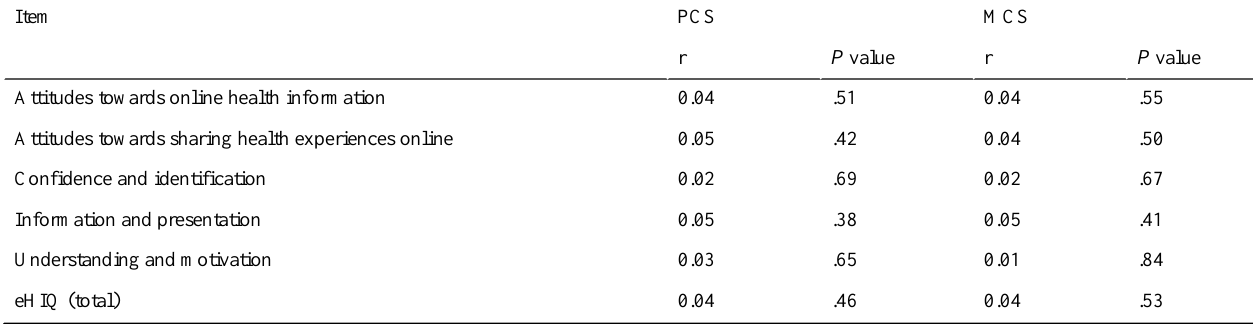
Table 4. Correlations of online health information–seeking subscales with health status.